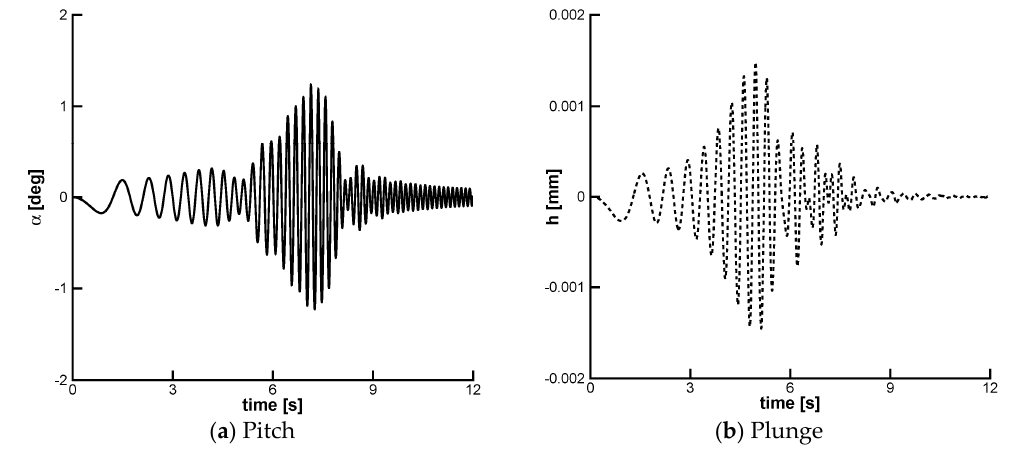
Figure 8. Time-domain aeroelastic response to the chirp input signal of Figure 7.